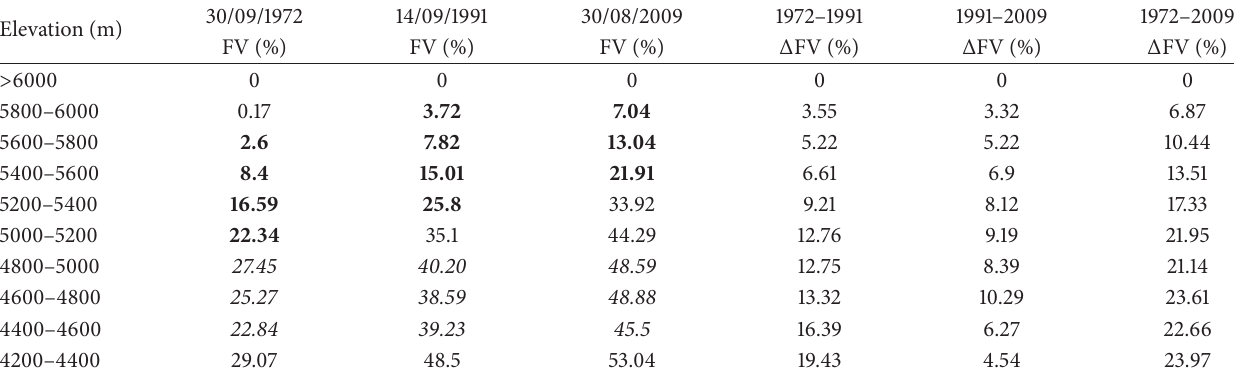
Table 1: Distribution and change of the fraction of vegetation cover in each elevation zone of the study area from 1977 to 2010. Elevation (m)